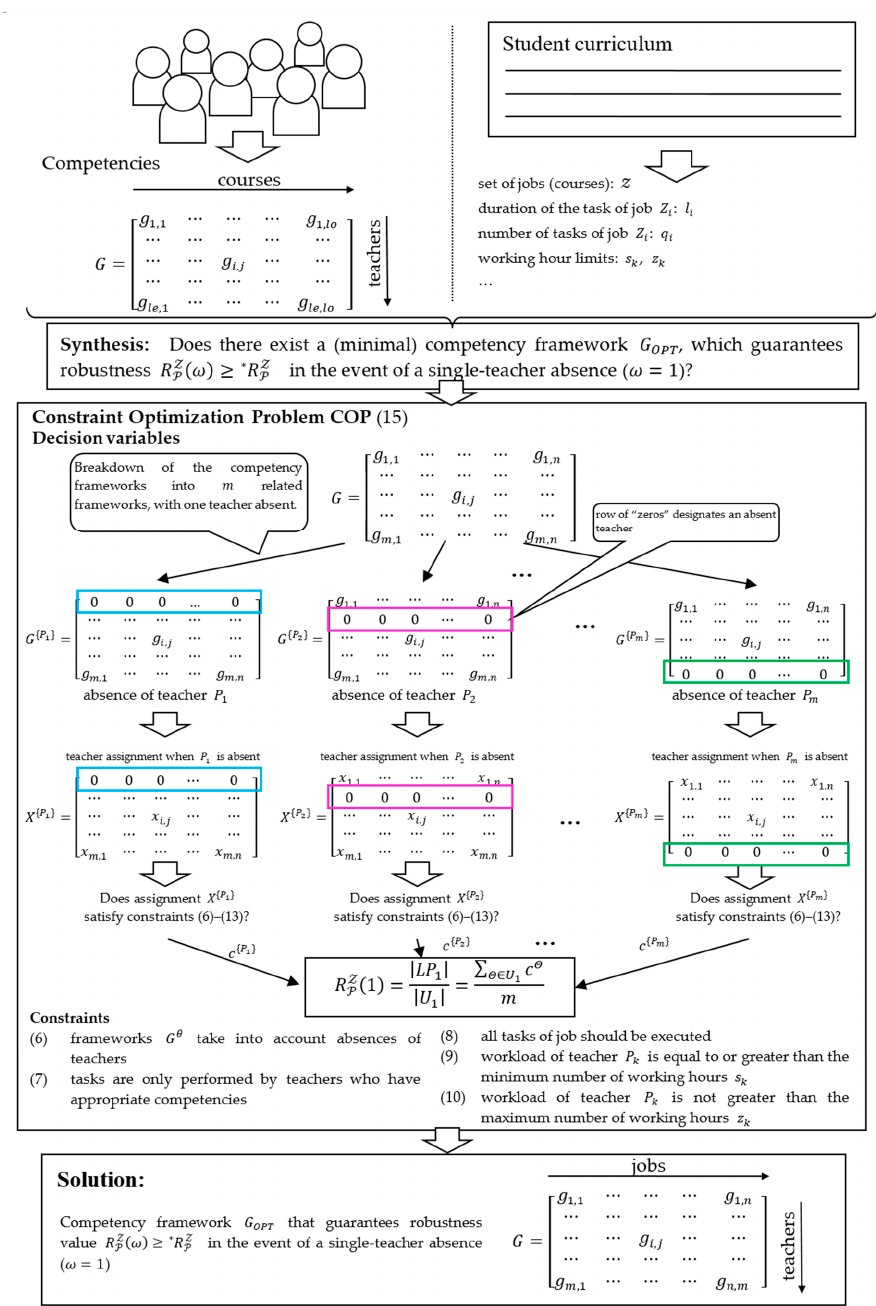
Figure 2. Model of Constraint Optimisation Problem (COP)-based synthesis of a robust competency Figure framework.